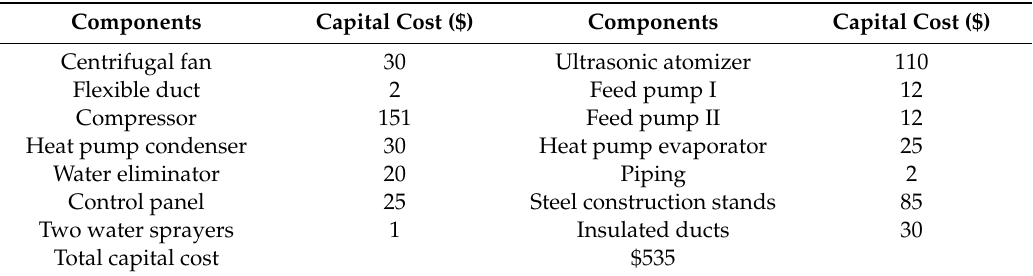
Table 2. Estimated capital cost for HDH components (2018 Egyptian market).